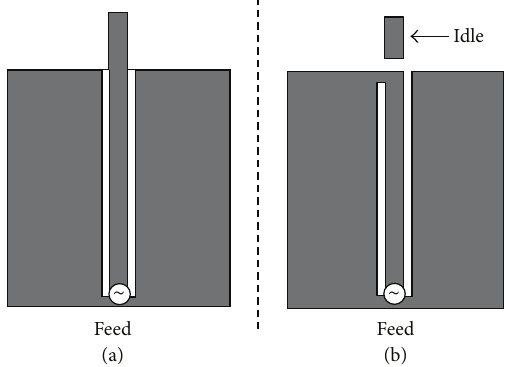
Figure 13: Feeding structure of the reconfigurable slot antenna: (a) CPW mode; (b) slotline mode